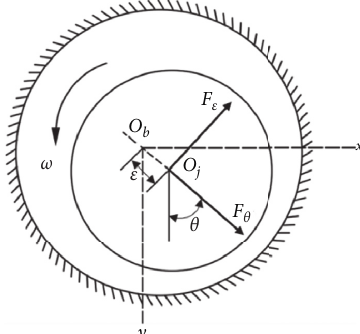
Figure 3: Model of sliding bearing.